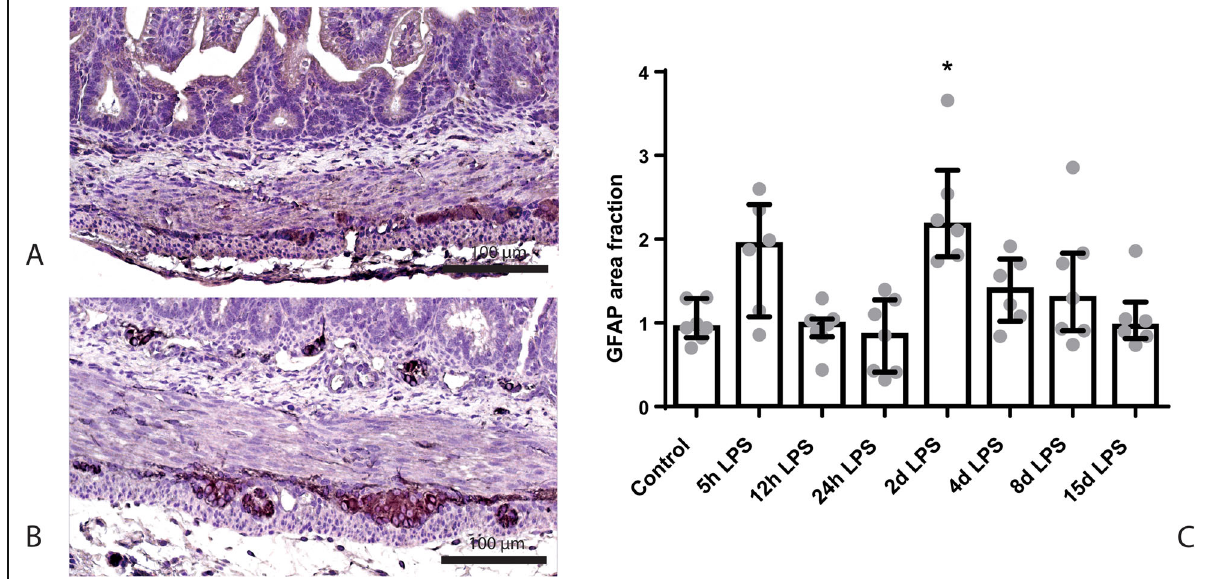
Fig. 6 Representative images of GFAP immunoreactivity in the submucosal and myenteric plexus of the control ( a ) and 2 days of IA LPS group ( b ). Area fraction of GFAP in the myenteric plexus ( c ) as fold increase over the control value. c GFAP-positive surface area in the myenteric plexus was increased in animals exposed to 2 days of IA LPS. * p < 0.05 compared to